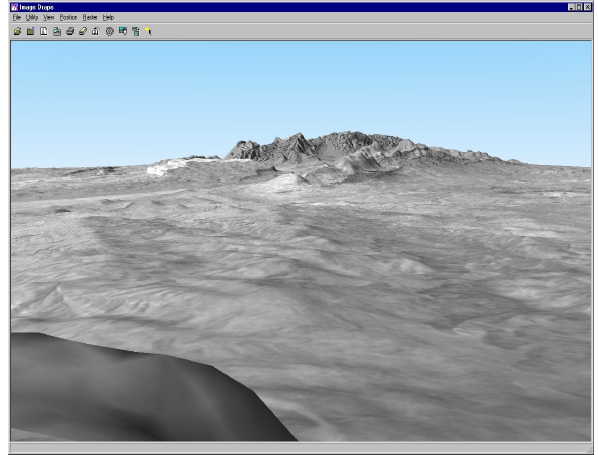
Figure 7. A perspective view over the western piedmont seen from Tar al–Sbai built from Russian topographic map data using Image Drape. Constructed by A. Vuorela 2001, 2002.